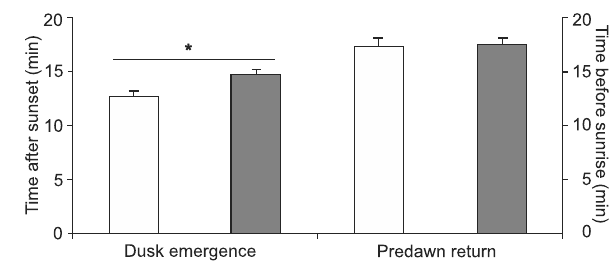
Figure 4. Time of dusk emergence (n = 63) and predawn return- ing (n = 63) of Tylonycteris pachypus in Longzhou County (empty column) and Guiping County (grey column), Guangxi, south China. All data are expressed as Mean ± SD. *p <